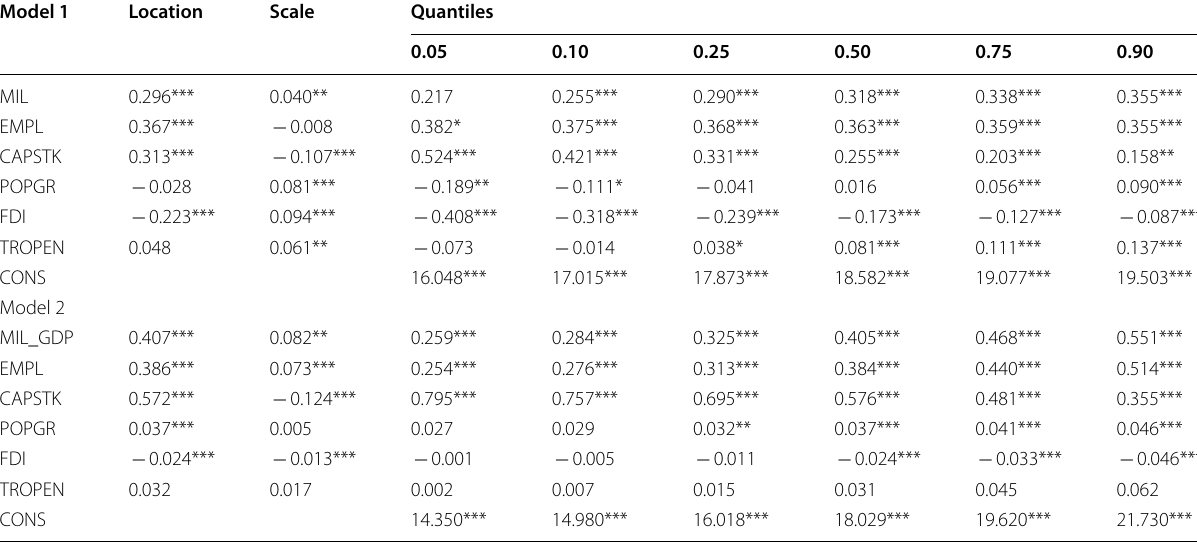
***, ** and * represent 1%, 5% and 10%, respectively RGDP, MIL, MIL_GDP, EMPL, POPGR, CAPSTK, FDI and TROPEN denote real gross domestic product (M’USD), military expenditure (M’USD), military burden, employment (M), population growth (%), capital stock at a constant price, 2017 (M’USD), foreign direct investment (%) and trade openness (%), respectively